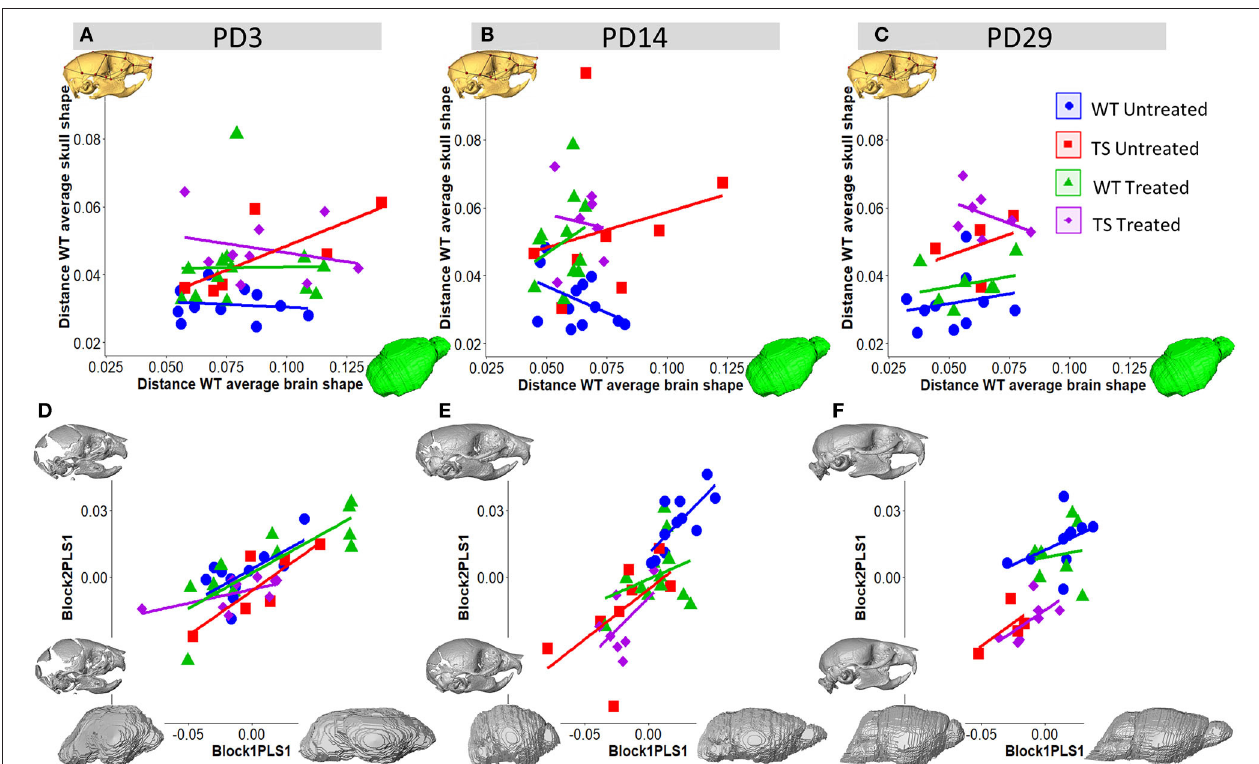
FIGURE 5 | Skull and brain integration over postnatal development in wild-type and Ts65Dn mice, and effects of GTE-EGCG. Correlations of brain and skull dysmorphologies estimated as Procrustes distances at (A) PD3, (B) PD14, and (C) PD29. Brain and skull shape covariation from a Partial Least Squares (PLS) analysis based on brain and skull landmarks at (D) PD3 (E) PD14 and (F) PD29 presented along with the morphings associated with the negative and positive values of both axes of PLS1. Brain landmarks were placed on the 3D renders of brains obtained from in vivo µ MRI scans and skull landmarks were placed on the surfaces of 3D renders from in vivo µ CT scans. Sample size: (PD3) WT = 11, TS = 6, WT Treated = 13, TS Treated = 9; (PD14) WT = 11 (12 dysmorphology), TS = 8, WT Treated = 11, TS Treated = 7; (PD29) WT = 10, TS = 4, WT Treated = 7, TS Treated =